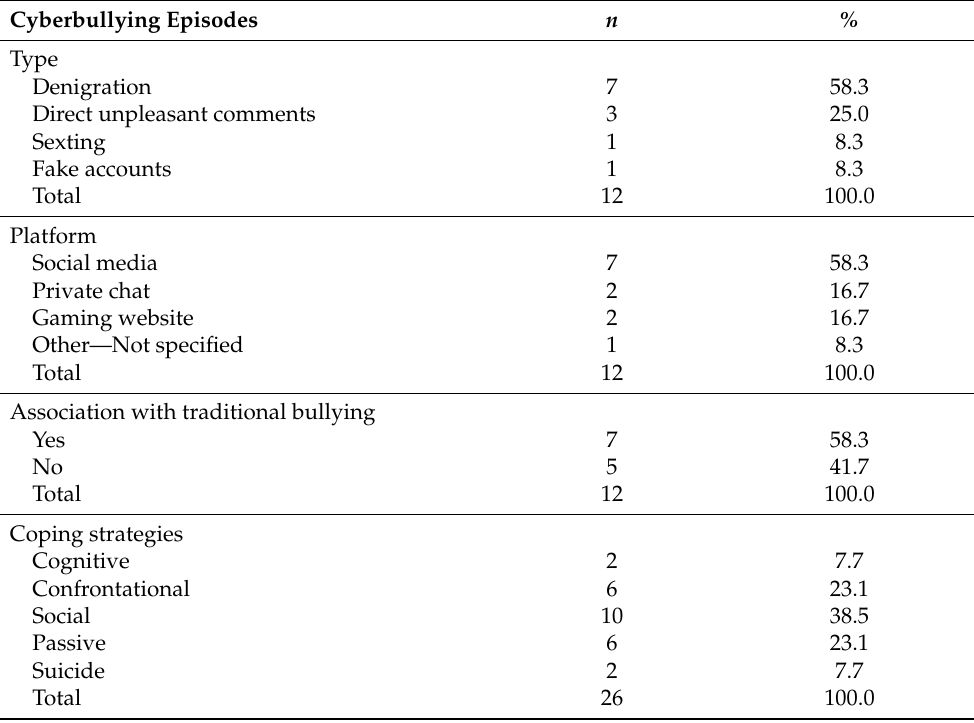
Table 3. Types of cyberbullying, platforms, association with traditional bullying, coping